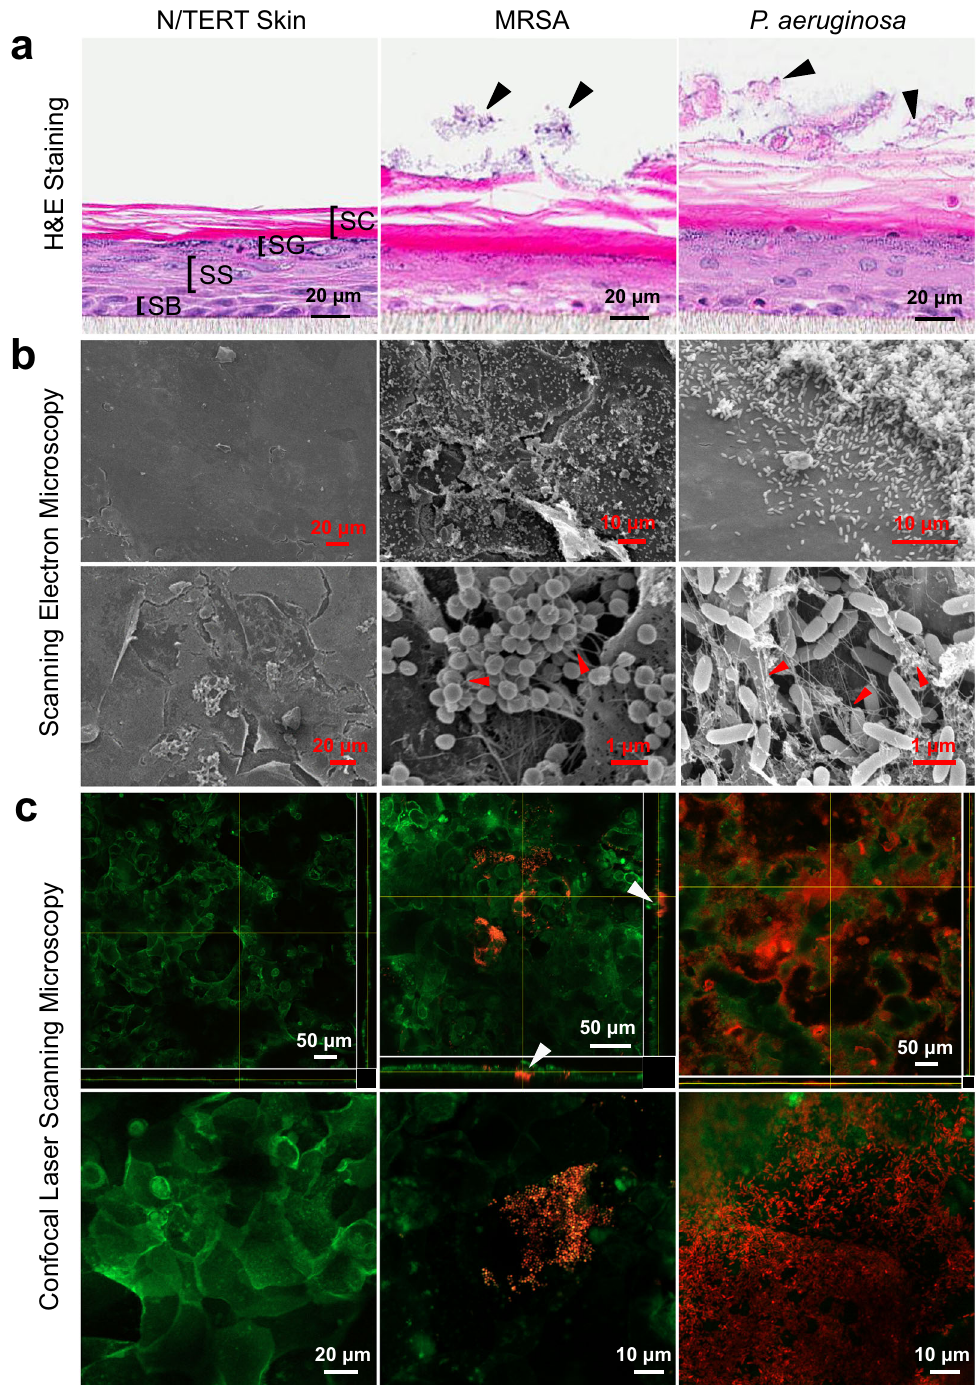
Fig. 1 Microscopic characterization of MRSA and PAO1 bio fi lms on N/TERT skin. a Control skin and skin infected with one million MRSA (USA300-LAC) or PAO1 cells were visualized with H&E staining 24 h after seeding. Cross-sections of skin layers corresponding to the stratum corneum (SC), stratum granulosum (SG), stratum spinosum (SS), stratum basale (SB) were readily visible. MRSA and PAO1 bio fi lm on skin are indicated with arrows. b Control skin and 1-day MRSA- lux (MRSA SAP149) or PAO1- lux bio fi lm surface structures were imaged by SEM. Arrows indicate fi lamentous material resembling extracellular matrix interconnecting the MRSA and PAO1 bio fi lm. c Control skin or skin spotted with fl uorescently tagged MRSA-FarRed or PAO1-mCherry was stained with CellMask TM Green Plasma Membrane Stain and visualized using confocal microscopy 24 h after infection. Arrows indicate MRSA-FarRed bacteria clusters penetrated underneath the surface of SC. Each of the bottom images in ( c ) is a zoomed-in region of the orthographic projection shown